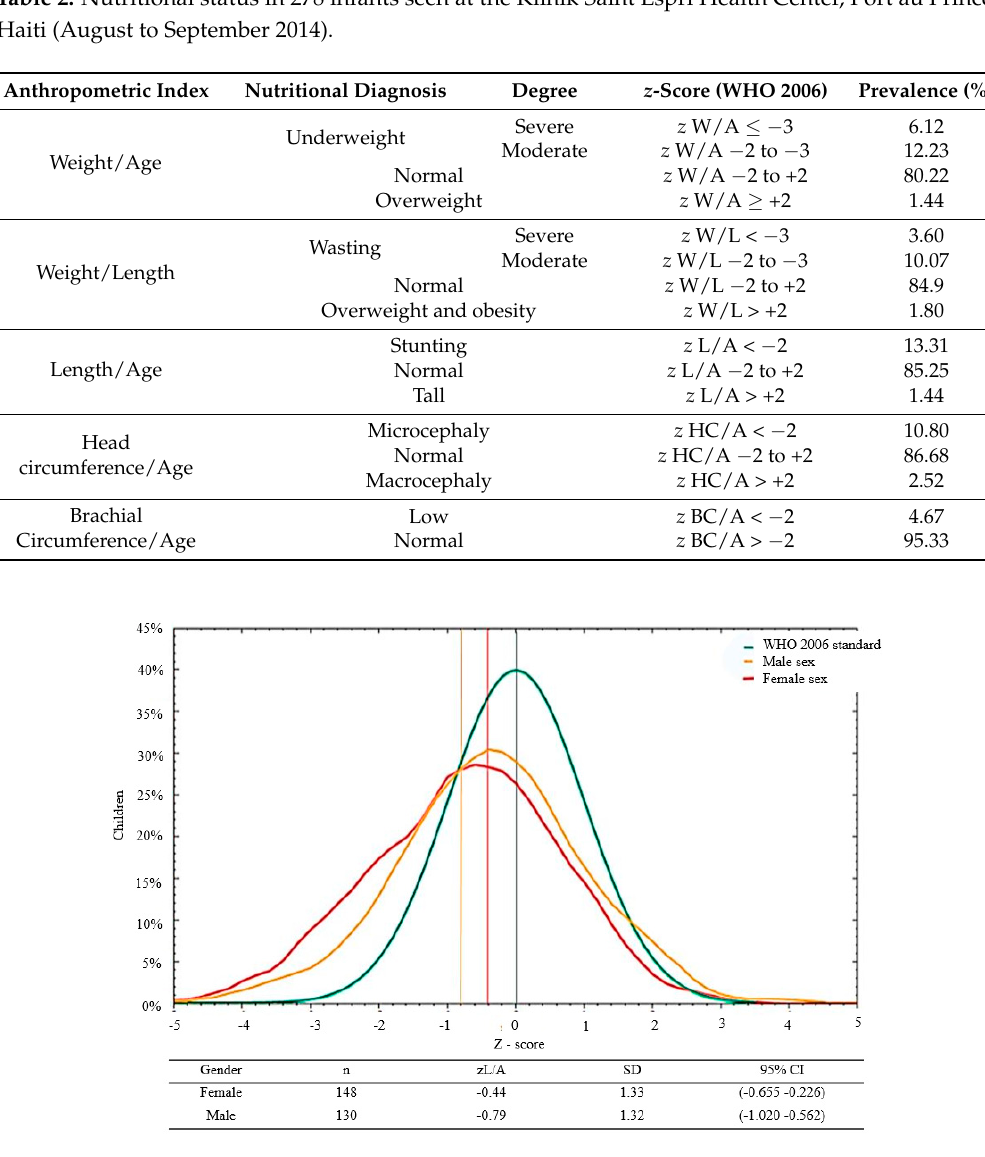
Figure 1. Distribution of L/A z -scores by sex* in 278 infants and young children seen at the Klinik Saint Espri Health Center, Port au Prince, Haiti (August 2014). Footnote: The green line indicates the WHO 2006 standard; the yellow line represents males and the red line females. * ANOVA, p =